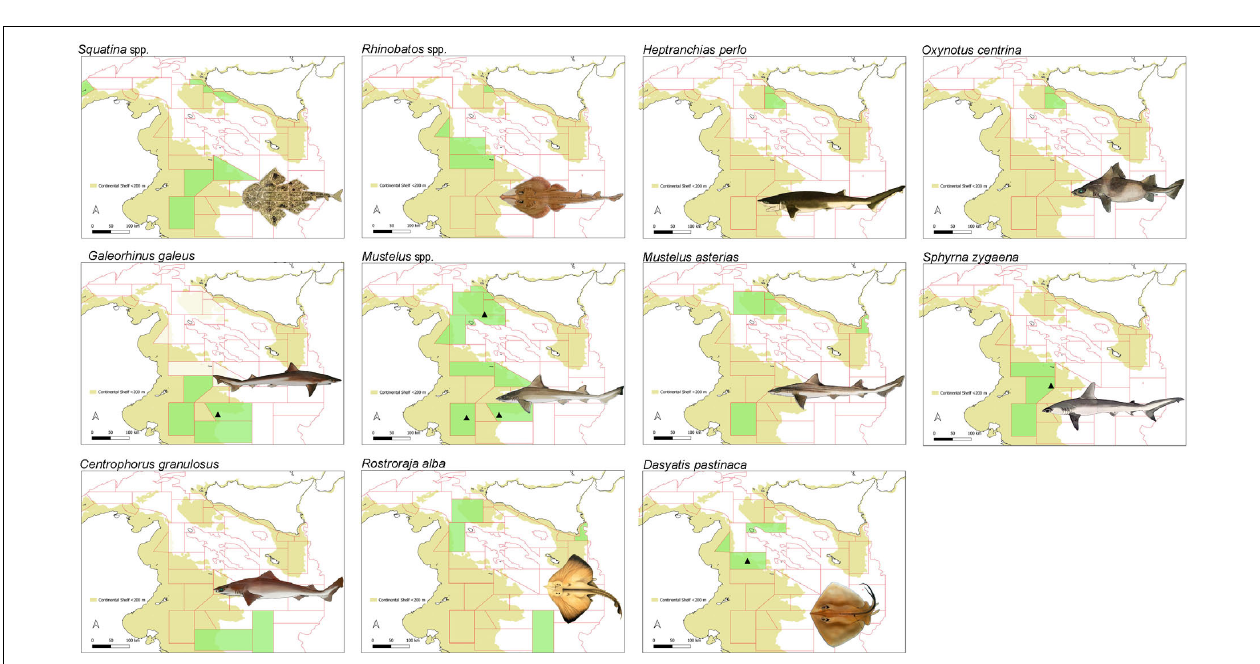
FIGURE 4 | Fishing areas where unusual high catches of threatened elasmobranchs were declared by fishers. Black triangles indicate observations for the period 1981–2000.